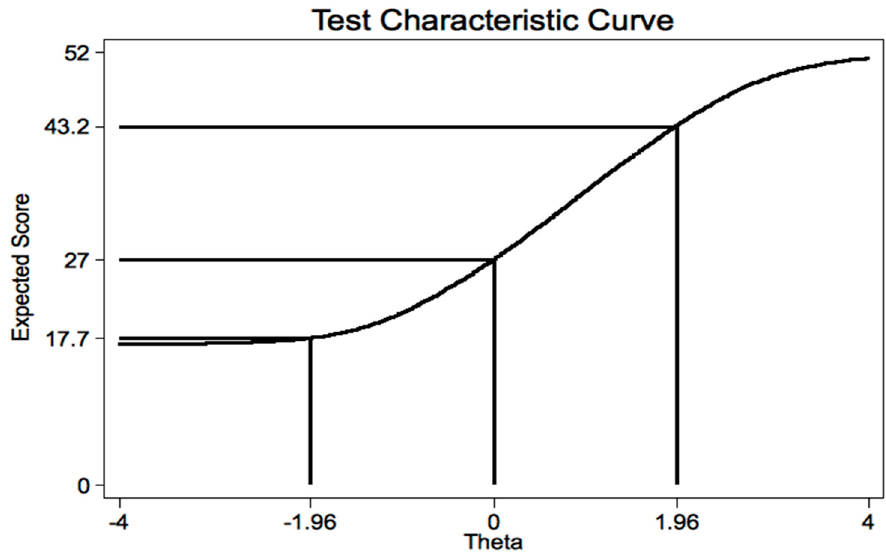
Figure 6. Test characteristic curve (TCC) from the partial credit model (IRT analysis) of the Italian version of CVSS.